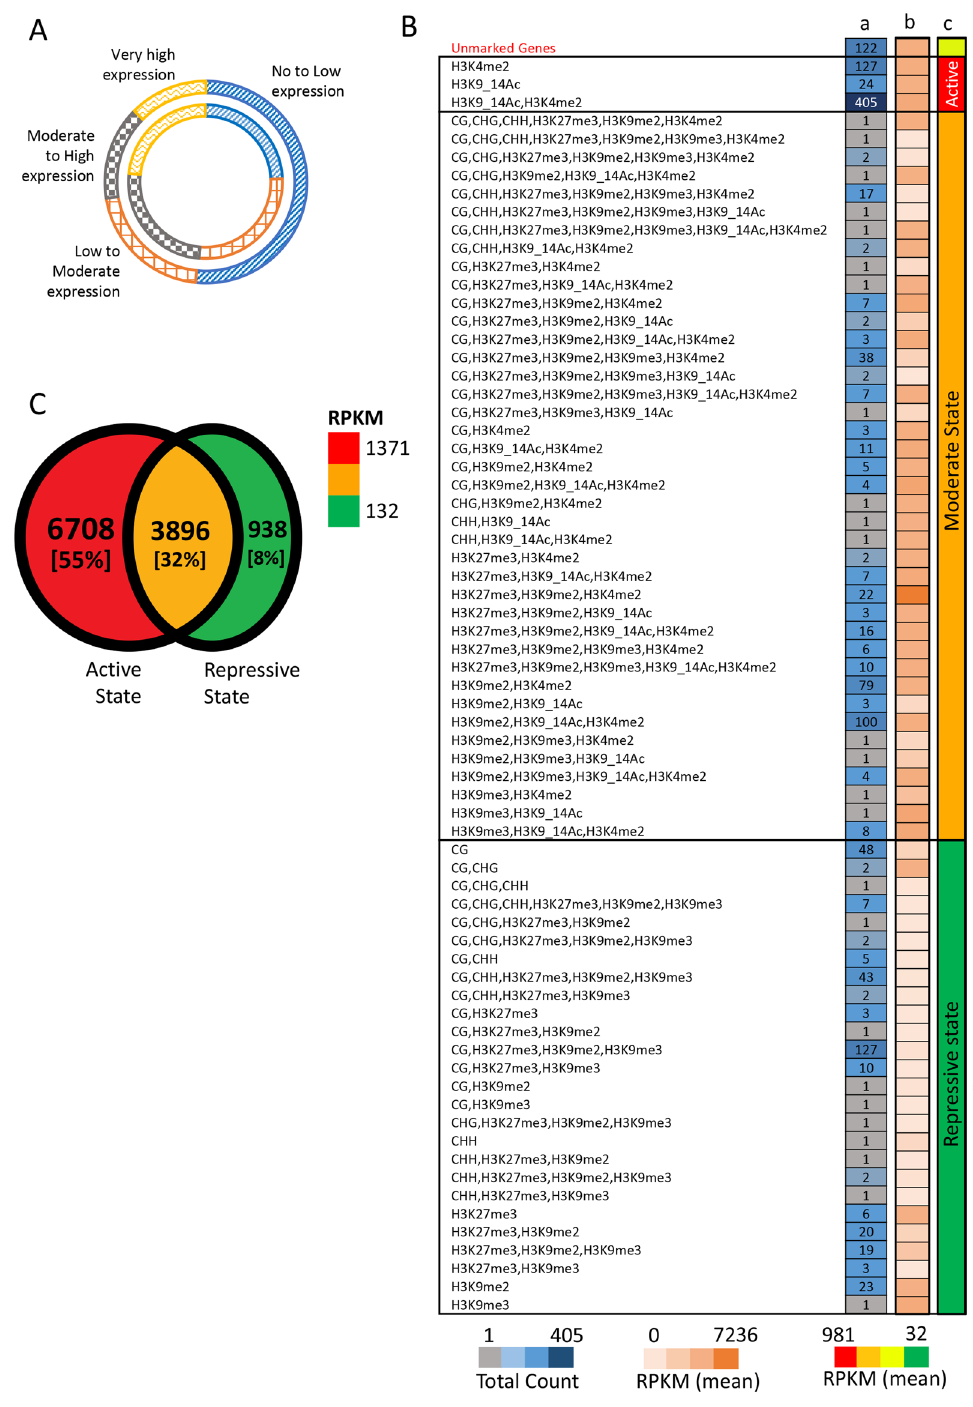
Figure 3. Dissecting the functional characteristics of Phatr3 proteome. ( A ) Comparison of the expression profile of the proportion of new genes (outer circle) with that of the proportion of unchanged gene models (inner circle). The expression profiling of all the Phatr3 genes are done based on quartile method, where first and last quartile reflects genes with no/low expression and very high expression, respectively. ( B ) and ( C ) summarize various epigenetic modification and regulatory effects on Phatr3 gene models and only new gene models in Phatr3. ( B ) Specifies the regulatory effects of the co-localization of different modifications/marks on the novel genes. The number of genes corresponding to each combination of co-localizing marks is provided in column a. The average expression of these genes is represented as a heat map in column b. Compared to the unmarked genes the regulatory effect of the co-localization of different epigenetic modifications is seen to maintain three chromatin states, represented with column c with few exceptions with expression that can be higher or lower than expected. This cases are likely due to the presence of additional active or repressive marks that were not studied. * Indicates where the average expression (normalized DESeq counts) is